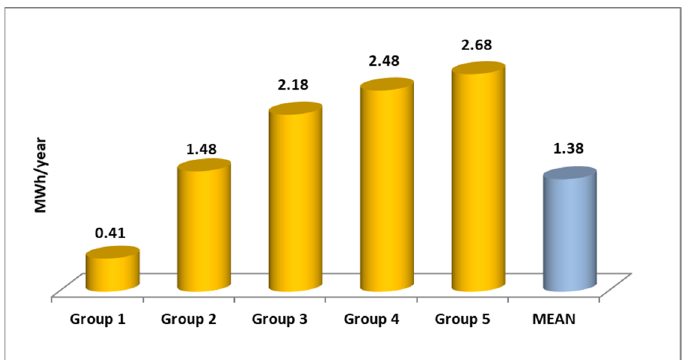
Figure 7. Mean energy consumption per inhabitant by group of cities.